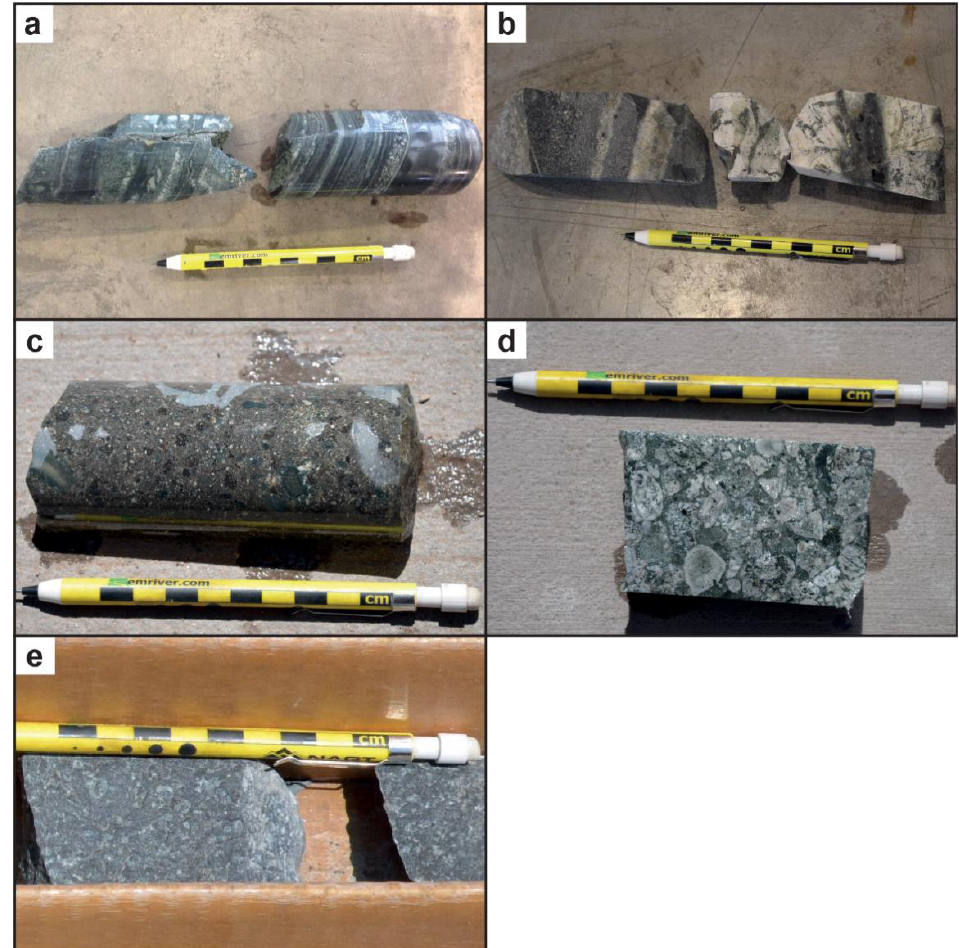
Figure 3. Variably hydrothermally altered and metamorphosed lithologies of the Coya Machalí Formation. ( a ) Finely laminated siltstone and mudstone showing chlorite and epidote alteration (DM1AG03). ( b ) Silicified siltstone and sandstone (DM1AG16). ( c ) Coarse-grained volcaniclastic sandstone (DM7AG03). ( d ) Conglomerate lithology with predominantly rounded dacitic and andesitic clasts (DM7AG07). ( e ) Propylitically altered basaltic andesite (DM7AG29).